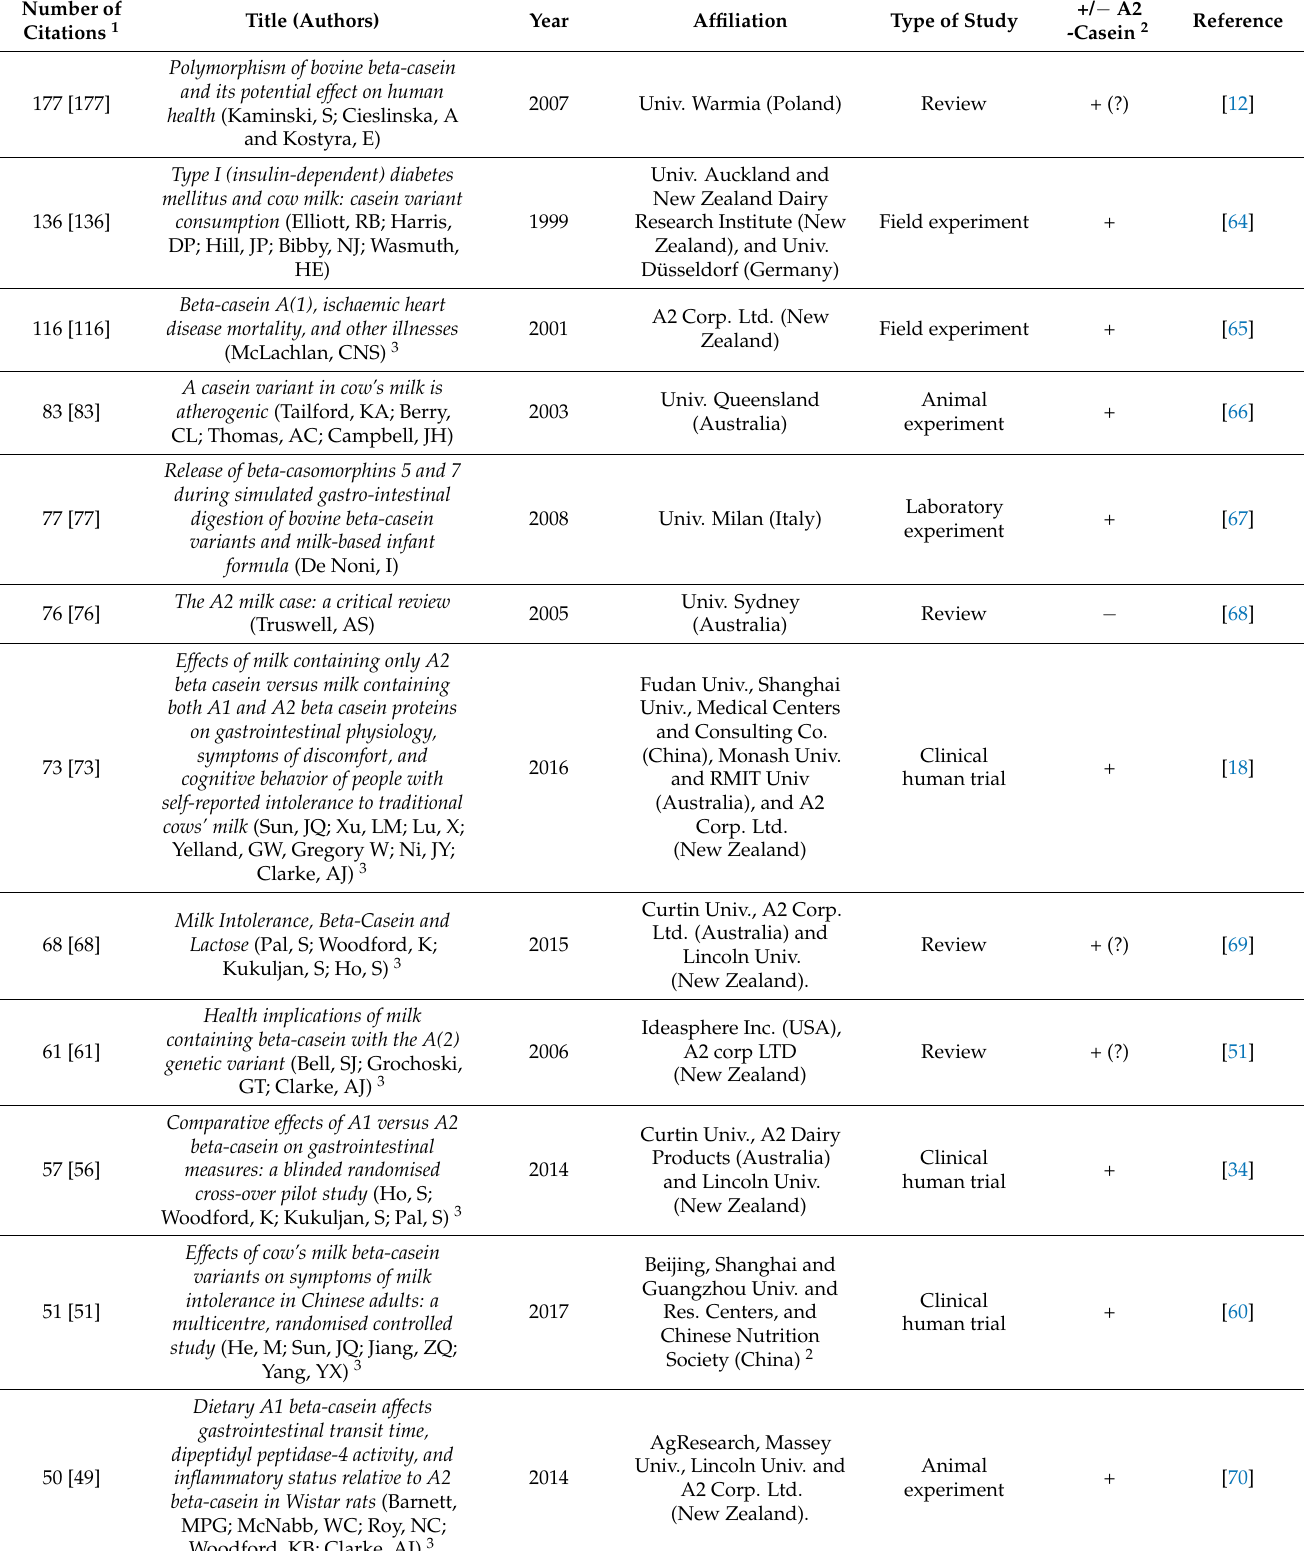
Table 4. Articles about A2 β -casein and health outcomes with more than 50